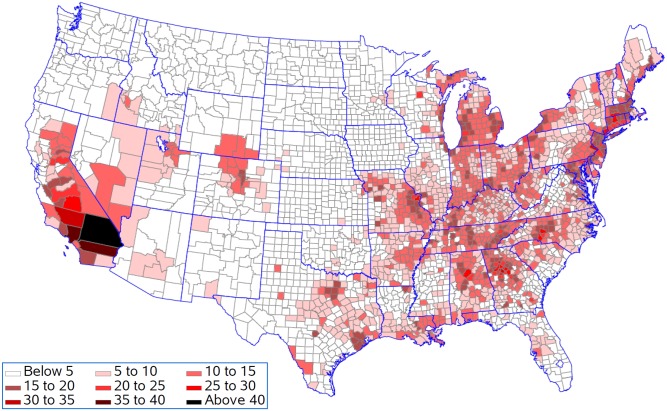
Increase in death from cardiovascular diseases (per 100,000 population per year) resulting from being above the national 25th percentile for each pollutant.